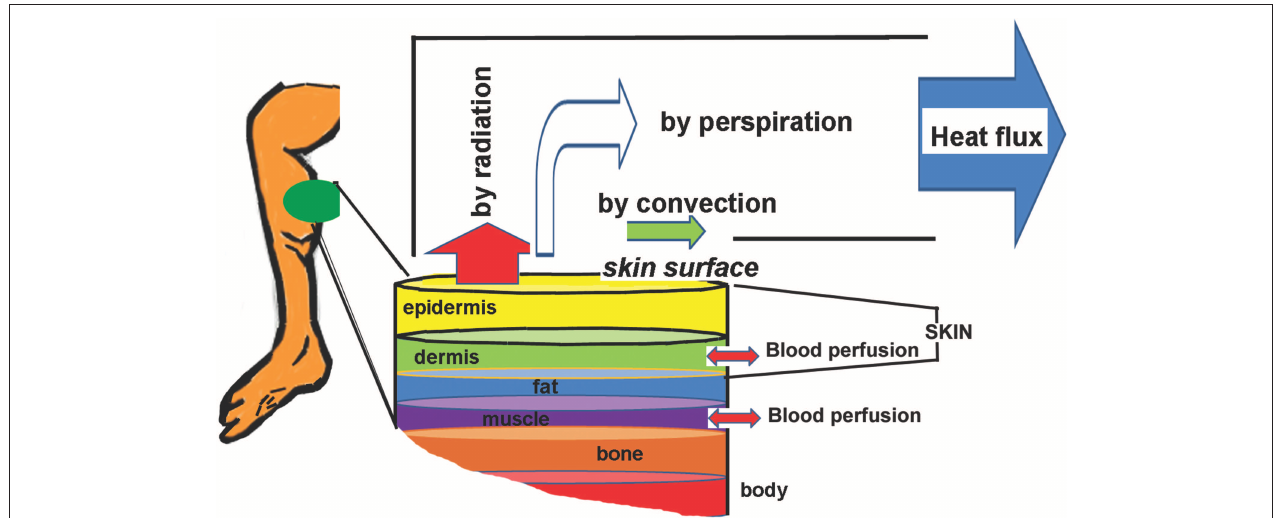
FIGURE 1 | Schematic presentations of human body layers: see explanation in the